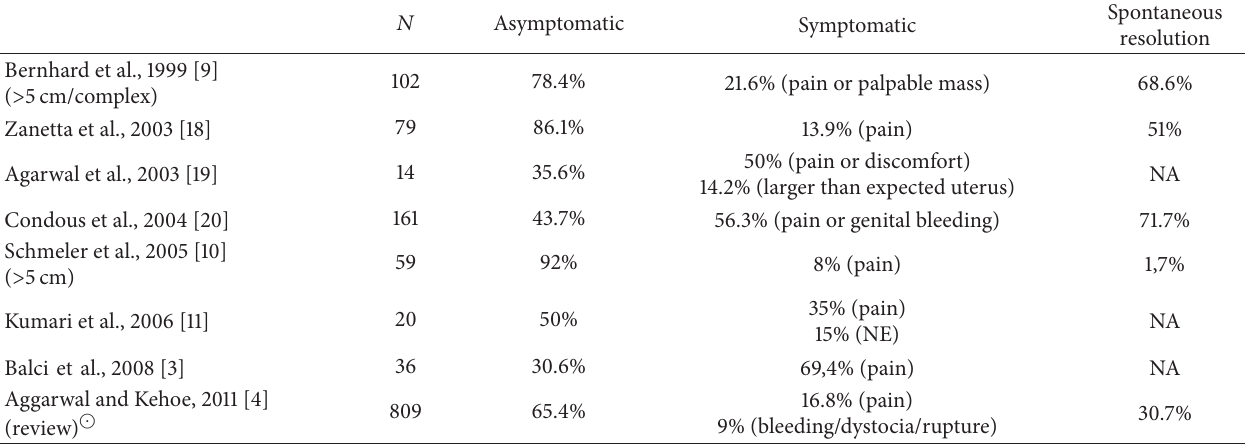
Table 2: Clinical presentation and frequency of spontaneous resolution of adnexal masses in pregnancy [3, 4, 9–11,